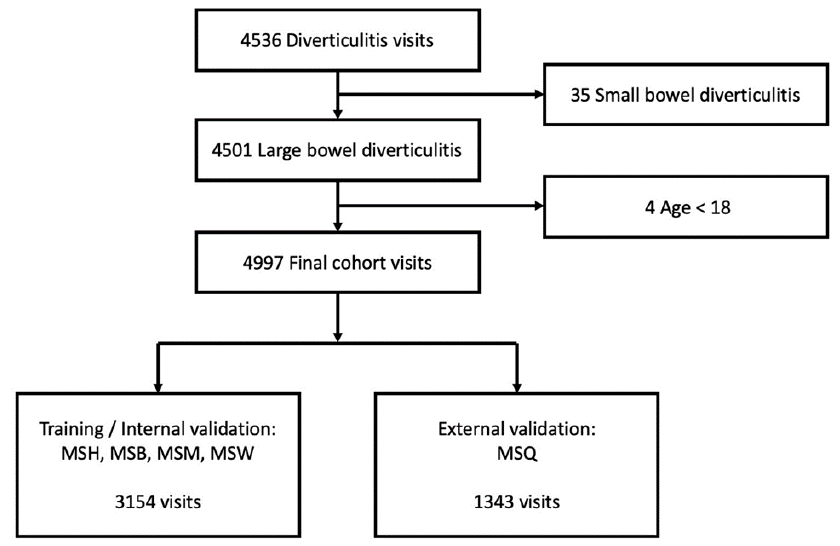
Figure 1. Study flow chart. Abbreviations: Mount Sinai Hospital MSH; Mount Sinai Brooklyn MSB; Mount Sinai Morningside MSM; Mount Sinai West MSW; Mount Sinai Queens MSQ. Overall, 129 (2.9%) visits had complicated diverticulitis (59 surgical intervention, 71 drainage intervention, seven mortality cases; with overlap). Table 1 presents the charac- teristics of the entire cohort, stratified by complicated diverticulitis status. Table 1. Baseline characteristics of the study cohort comparing the complicated AD group to the uncomplicated AD group. Uncomplicated AD Complicated AD ( n = 4368, 97.1%) ( n = 129, 2.9%)